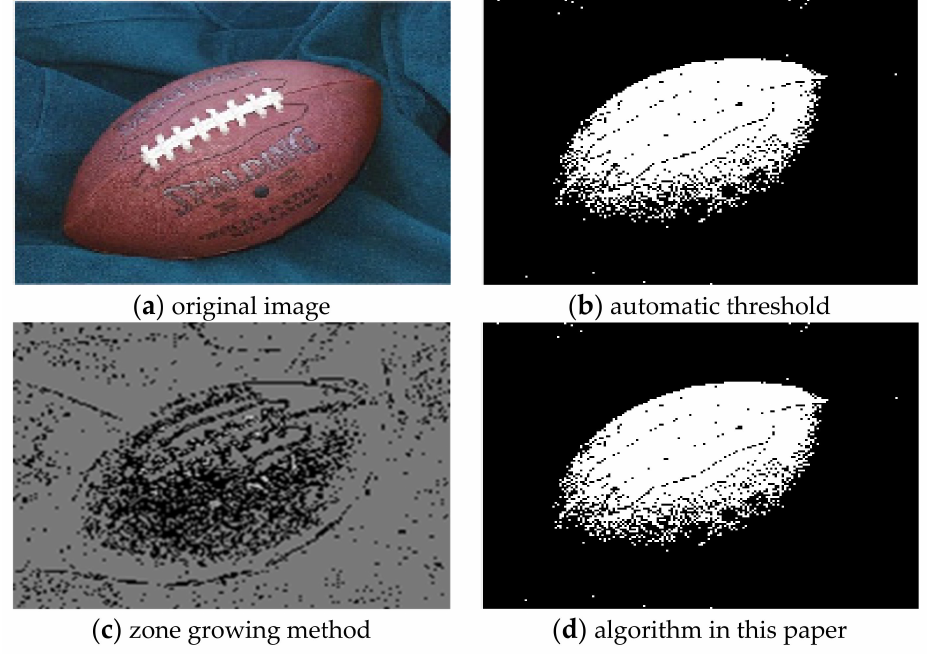
Figure 5. Comparison of Football image segmentation results. For the comparison of the three algorithms on Colored Chips image, the experimental results are shown in Figure